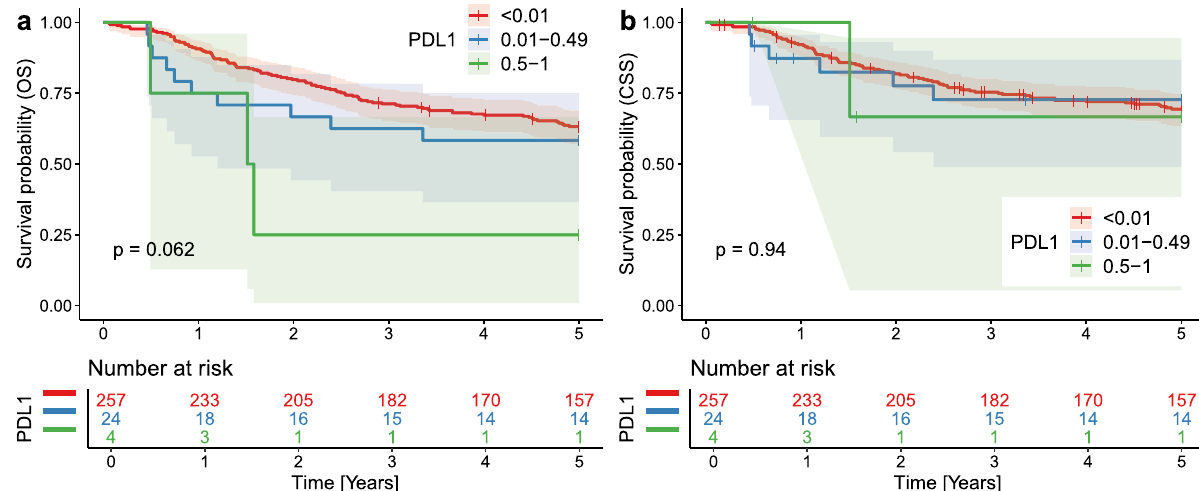
Figure 4. Entire cohort, Kaplan Meier curves documenting ( a ) worse 5-year overall survival (OS) in patients with CRC strongly (50–100% tumor cells) expressing PD-L1 compared to weak and moderate expressors and negative cases; ( b ) no significant differences in cancer-specific survival (CSS). P values from the log-rank test < 0.05 indicate a significant difference in